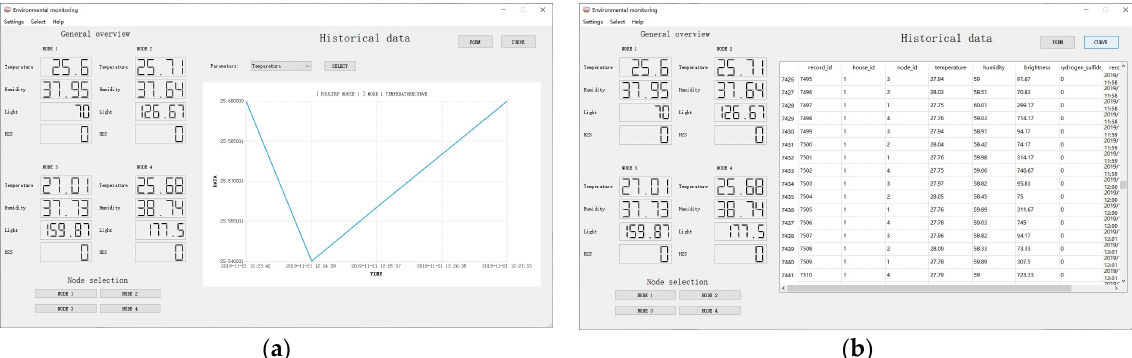
Figure 10. The software interface effect of an environmental information management module, ( a ) fluctuating presentation of environmental data, ( b ) historical environmental data, including temperature, humidity, light, H 2 S concentration, ammonia concentration, carbon dioxide concentration, etc.